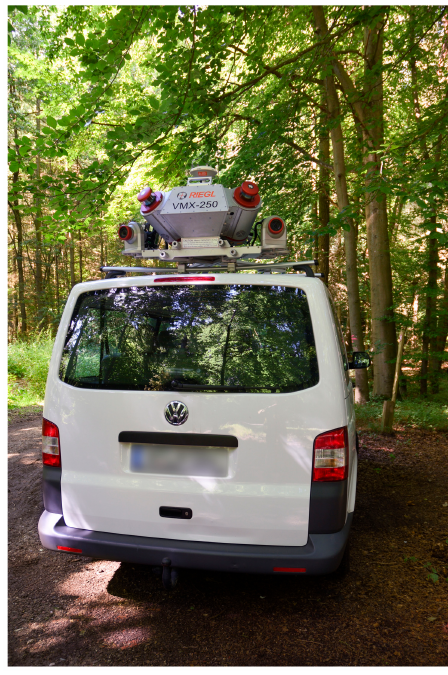
Figure 1. Mobile Mapping System Riegl